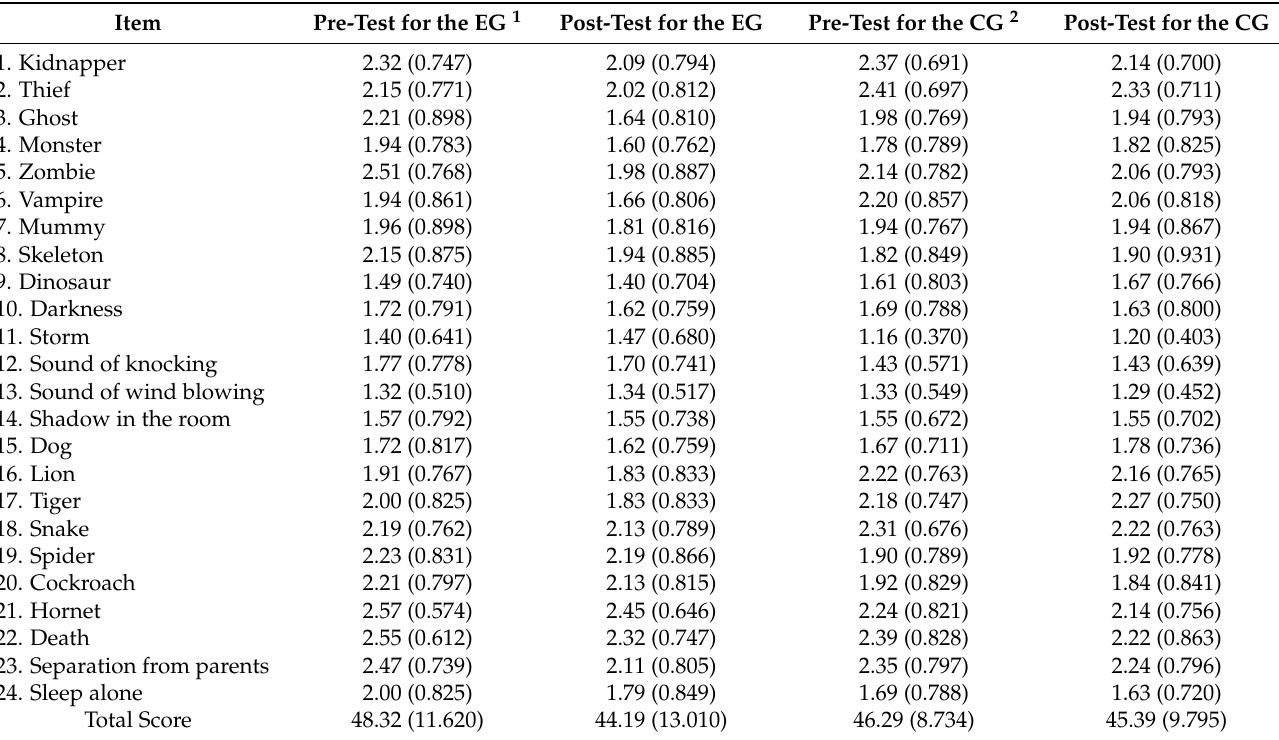
Table 9. Mean and standard deviation of experimental